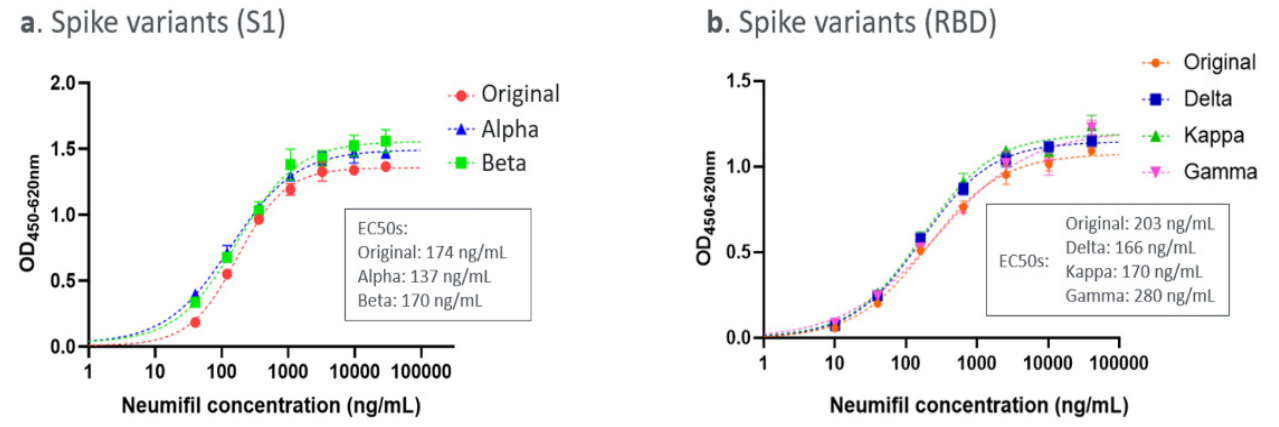
Figure 6. Detection of Neumifil binding to SARS-CoV-2 Spike proteins tested by ELISA technique: ( a ) spike S1 and ( b ) spike RBD. The dotted lines represent 4PL curve fits of the data. Inset: EC50 values for each variant.